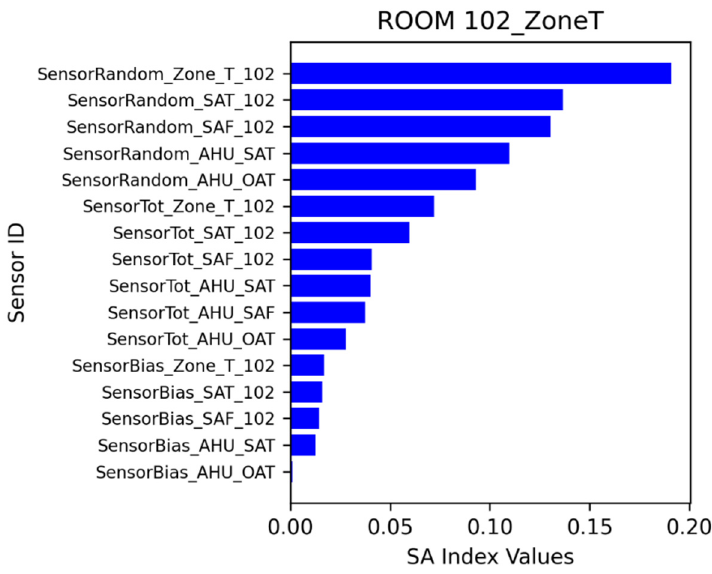
Figure 25. SA for zone 102 air temperature.